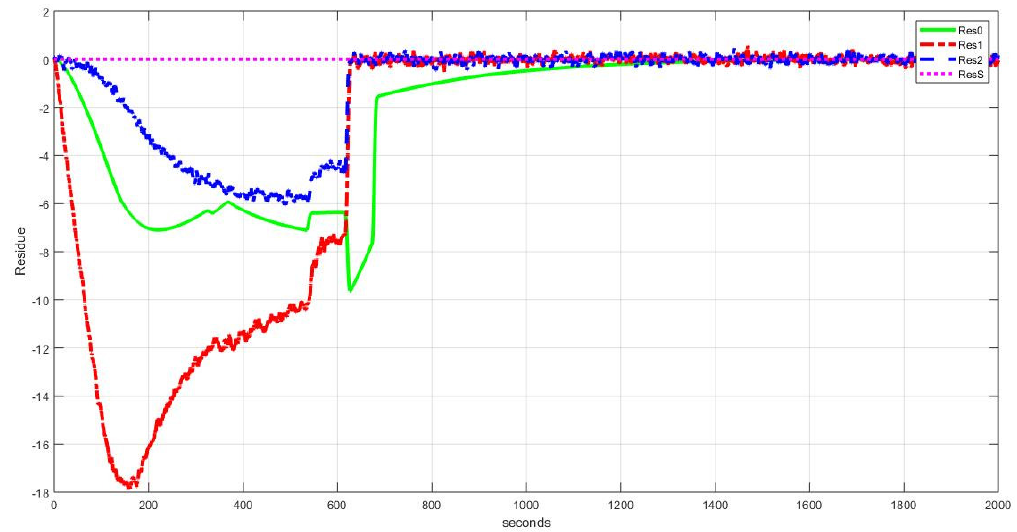
Figure 9. Pond residues for the saturation fault of sluice gate w 1 .